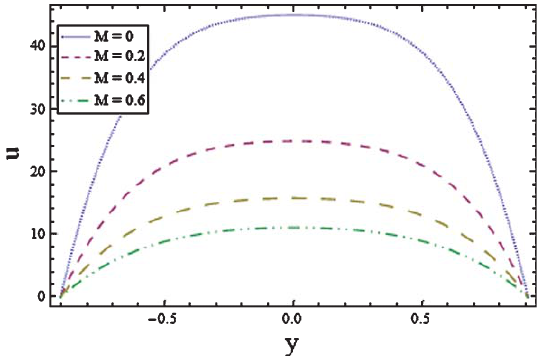
Fig. 4. Plot of longitudinal velocity u for various values of the Eyring-Powell fluid parameter M with (cid:15) = 0 . 2, x = 0 . 02, t = 0 . 1 , K = 0 . 02 , E = 0 . 3 ,E = 0 . 2 , and E = 0 . 1 2 3